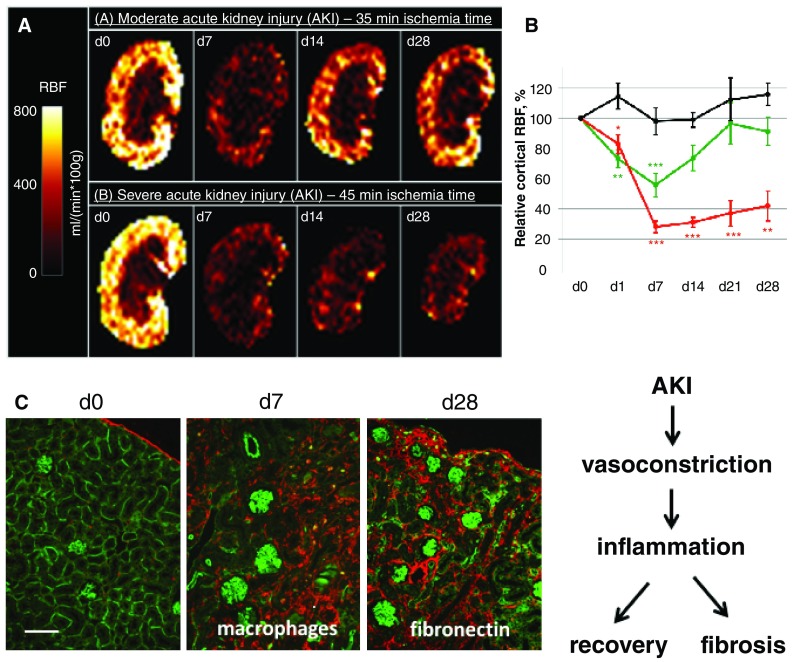
Arterial spin labeling (ASL) in a model of acute kidney injury (AKI).
A) ASL in a mouse model of transient AKI induced by short-term ischemia/reperfusion injury (IRI; 35 minute clipping of the renal pedicle, green line, upper row) compared to prolonged ischemia time (45 minute clipping and resulting in renal fibrosis, red line, lower row).
B) Quantification over time shows the permanent impairment of renal cortical blood flow due to prolonged ischemia time causing renal fibrosis. The black line represents the contralateral not clipped kidney. Reproduced with permission from Hueper
et al.
19.
C) Histology (45 minute IRI) shows lectin-perfused kidneys where patent capillaries are stained in light green in the healthy kidney (d0 double stained in red with fibronectin), at d7 macrophages (red) are infiltrated in area with loss of patent capillaries, and at d28 hypoperfused areas show enhanced scarring with fibronectin expression (red; bar represents 100 µm). RBF, renal blood flow.